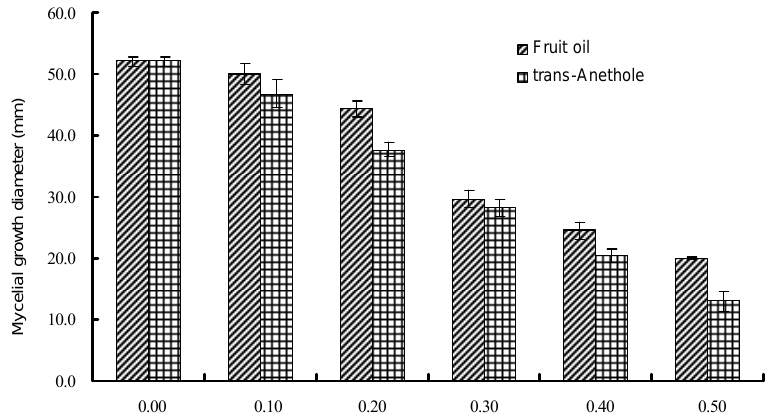
Figure 2. Effect of vapor components in I. verum fruit oil and trans -anethole on mycelial growth of B. theobromae by vapor contact